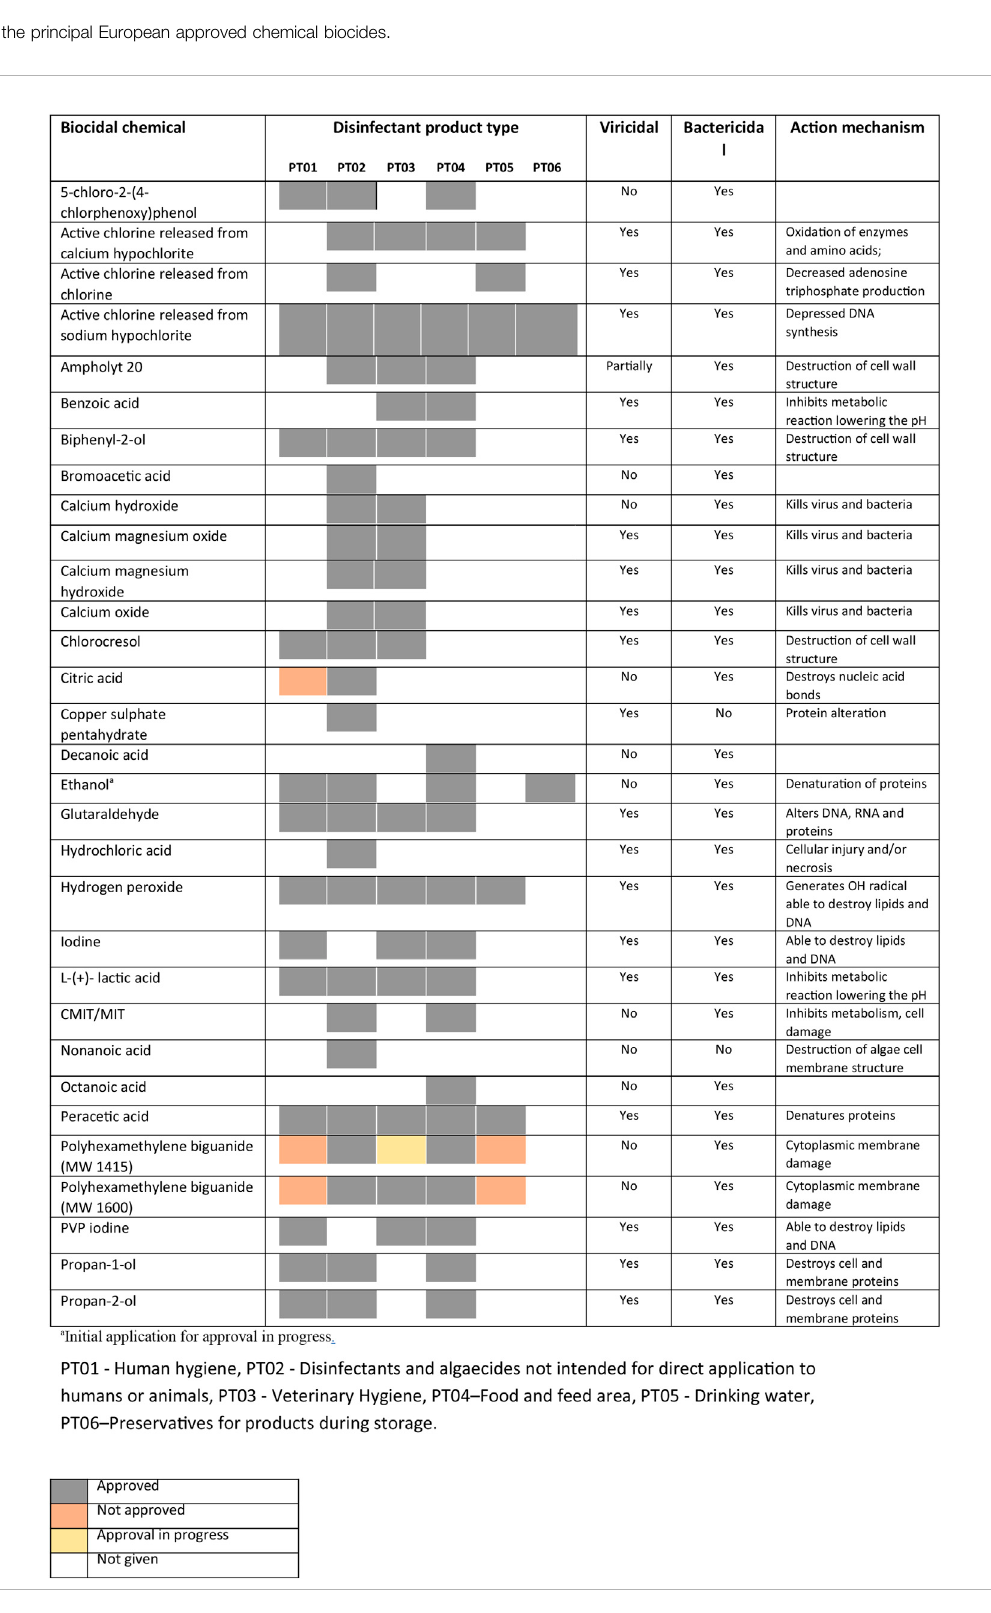
Frontiers in Chemical Engineering |